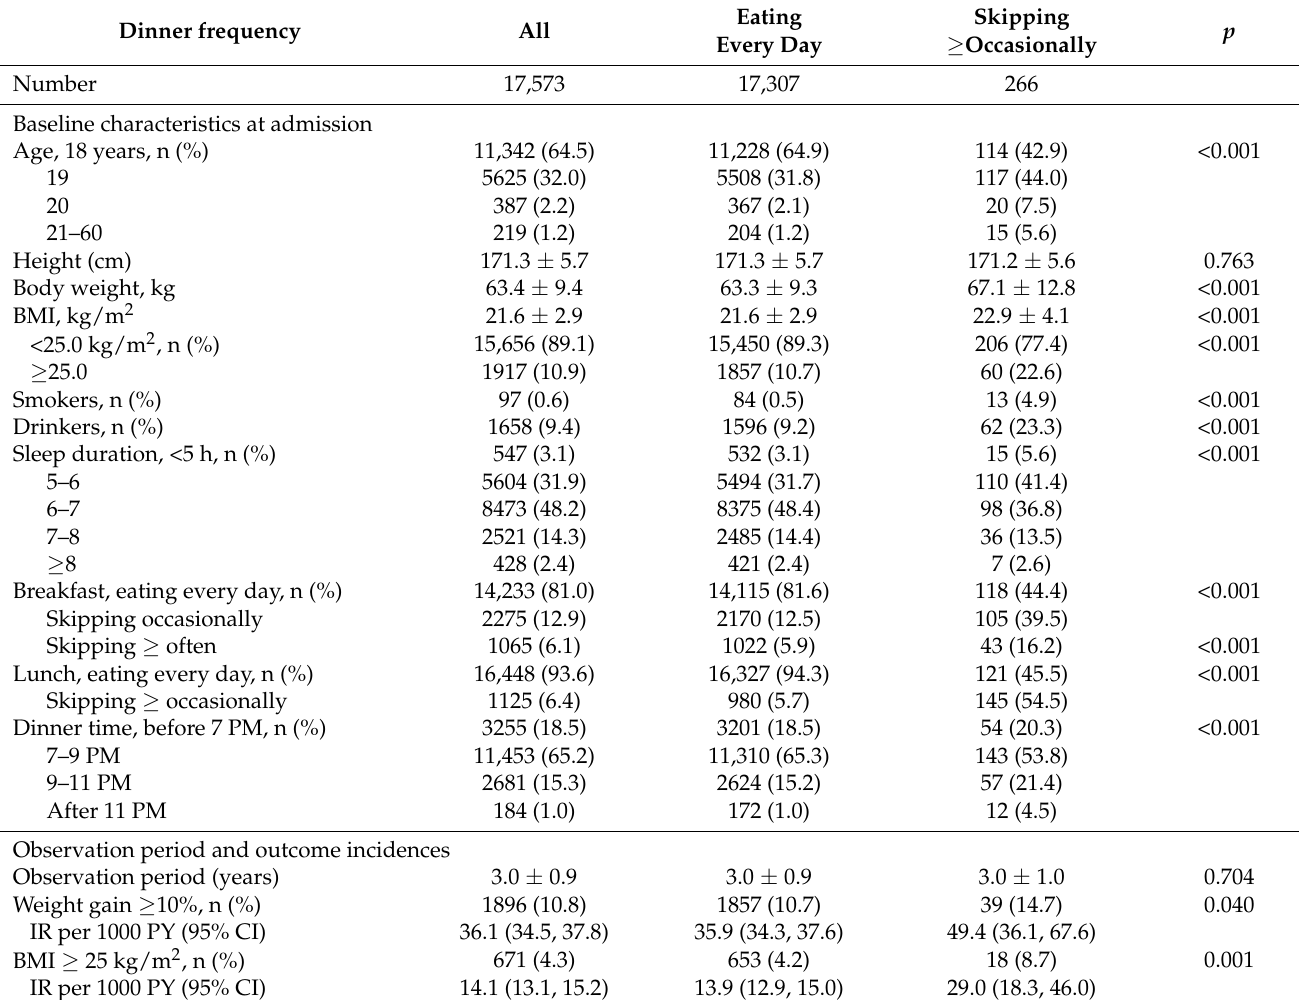
Table 1. Baseline characteristics, observation period, and outcome incidences of 17,573 male students stratified by din- ner